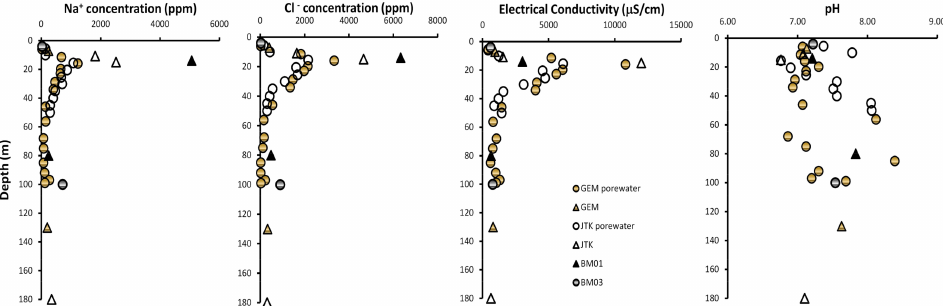
Figure 4. Water content, bulk density and specific gravity of Semarang-Demak